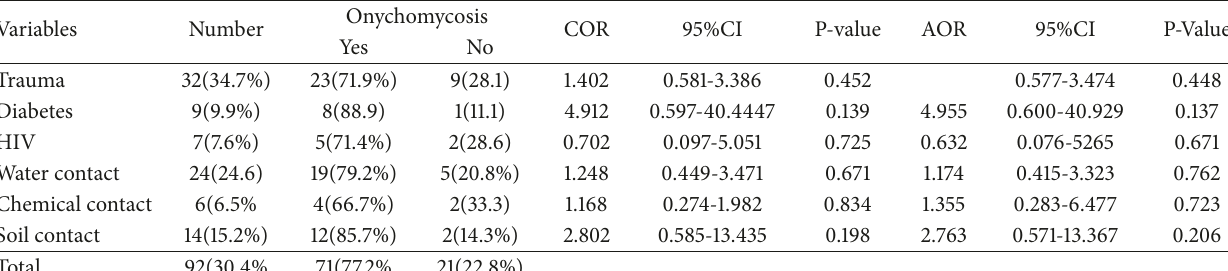
Table 4: Association of onychomycosis with risk factors